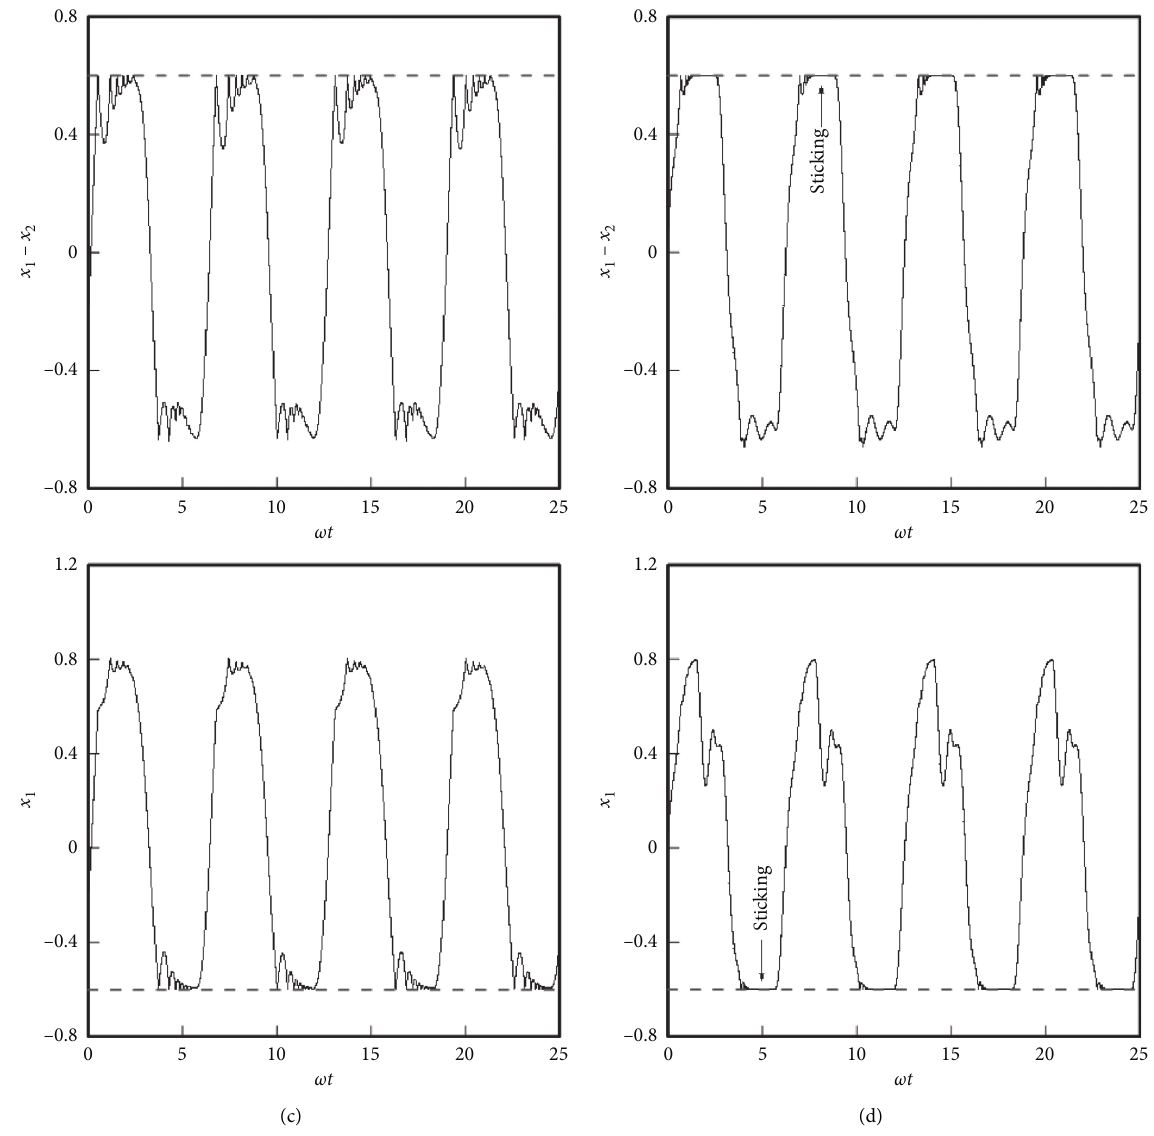
Figure 4: Time history diagram of complete chattering-impact vibration transition process of mass M vibration. (b) ω � 0.295,1-5-6 vibration. (c) ω � 0.275,1 − p − p . (d) ω � 0.20,1 − p − q